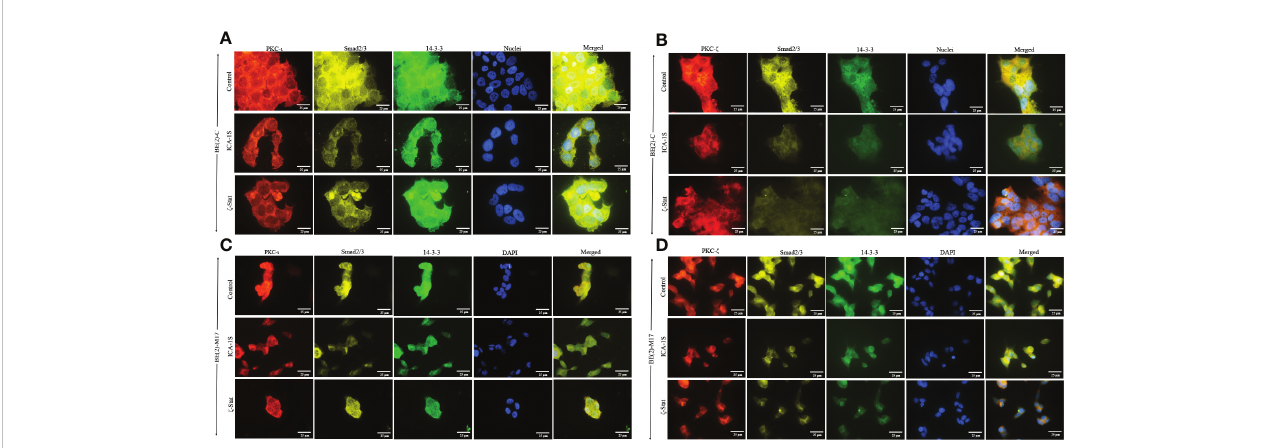
FIGURE 6 PKC- i and PKC- z associations with 14-3-3 and Smad2/3 in NB cells. BE(2)-C and BE(2)-M17 (2.5×10 3 ) cells were seeded in chamber slides and at 24 h post-seeding time, fresh media was supplied and inhibitor treatments (50 µM of ICA-1S and 75 m M of z -Stat) were applied every 24 h for 48 h. (A) Immuno fl uorescence staining of PKC- i (red panel), Smad2/3 (yellow panel), 14-3-3 (green panel) and nuclei (blue panel), along with the merged image of all four colors, for BE(2)-C cells treated with either ICA-1S (50 µM) or z -Stat (75 µM) against its control. (B) Immuno fl uorescence staining of PKC- z (red panel), Smad2/3 (yellow panel), 14-3-3 (green panel) and nuclei (blue panel), along with the merged image of all four colors, for BE(2)-C cells treated with either ICA-1S (50 µM) or z -Stat (75 µM) against its control. (C) Immuno fl uorescence staining as in A) for BE(2)-M17 cells. (D) Immuno fl uorescence staining as in B) for BE(2)-M17 cells. Images were captured at 630x magni fi cation and experiments ( N = 3) were performed.